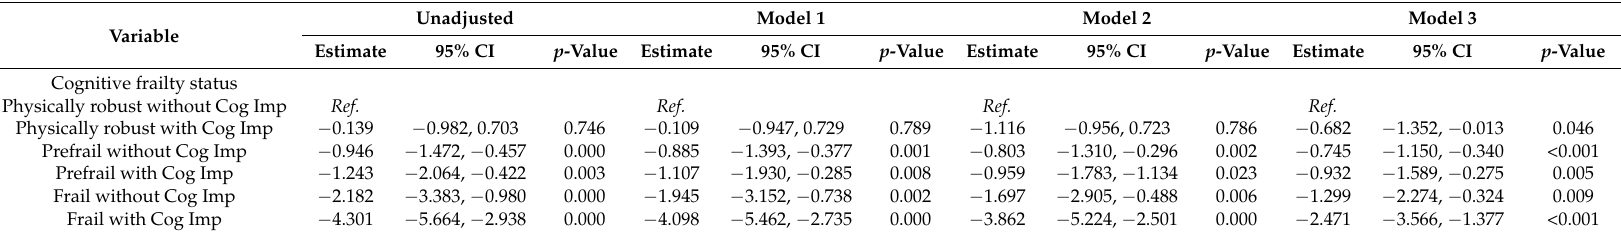
Table 4. Generalized linear model estimates for calf circumference (cm) according to physical frailty and cognitive impairment status in women. Unadjusted Model 1 Model 2 Model 3 Variable Estimate 95% CI p -Value Estimate 95% CI p -Value Estimate 95% CI p -Value Estimate 95% CI p -Value Cognitive frailty status Ref. Physically robust without Cog Imp Ref. Ref. Ref. Physically robust with Cog